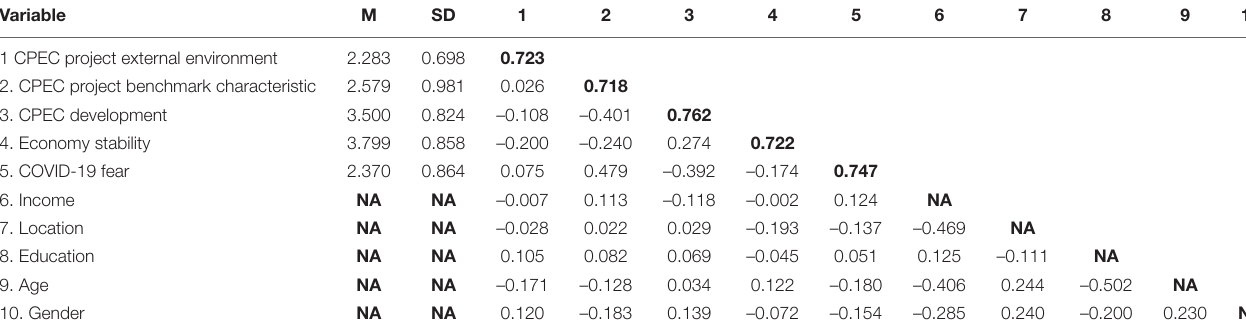
M, Mean; SD, Standard division. Diagonal elements are AVE square root. TABLE 3 | Results of confirmatory factor analysis.